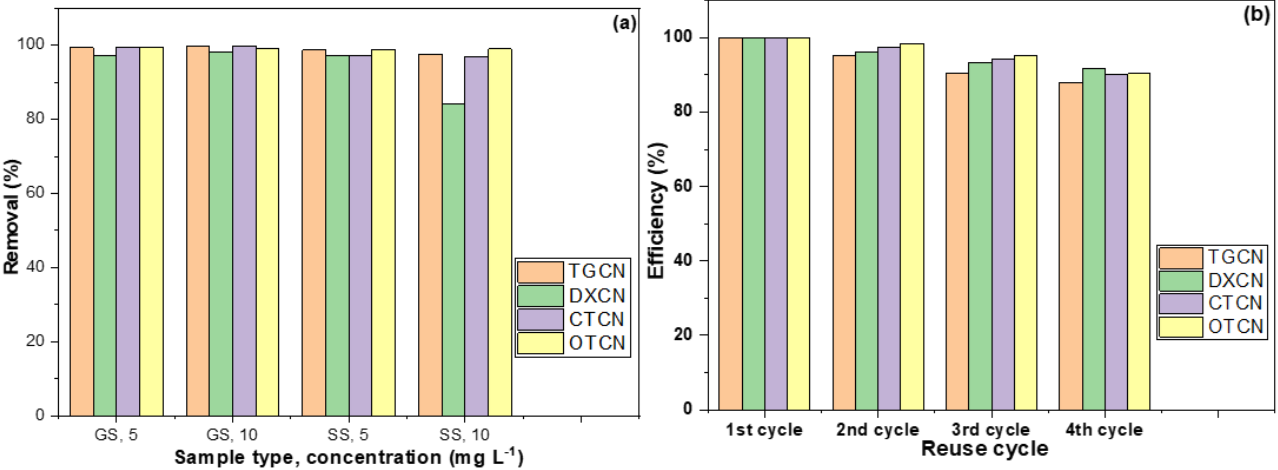
Figure 9. ( a ) Adsorption of TGCN, DXCN, CTCN, and OTCN on CRNPs from contaminated GS and SS; ( b ) the removal efficiency for TGCN, DXCN, CTCN, and OTCN by the regenerated CRNPs. ( c ) The surface area reduction to 200 m 2 g −1 for the regenerated CRNPs. 4. Conclusions CRMs have been derived from TPW via thermal carbonization. A concentrated phos- phoric acid was employed for pores opening, and the ball-milling process was utilized to down-size the CRMs and fabricate CRNPs. The batch adsorption experiments were fol- lowed to investigate the usability of CRNPs for removing TGCN, DXCN, CTCN, and OTCN from water. The agreement of TGCN, DXCN, CTCN, and OTCN sorption to the PSFO and the LFDM models indicated high adsorption affinity to the CRNPs. Further- more, the equilibrium results for the four drugs being fitted to the multilayer FIM sup- ported the high-affinity claim. The removal appeared to be exothermic and spontaneous physisorption for the four drugs. Although its efficiency decreased slightly during the consecutive reuses, the CRNPs possessed an excellent remediation efficiency for SS and